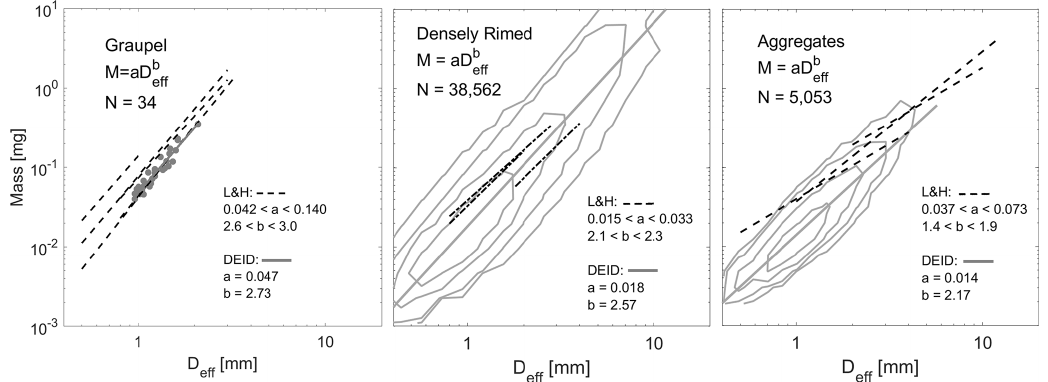
Figure 8. Mass–diameter relationships from the DEID (solid lines) sorted by type according to MASC imagery and compared with fits from Locatelli and Hobbs (1974), dashed lines. Contours are for 50th, 75th, 90th, and 95th percentile bounds.